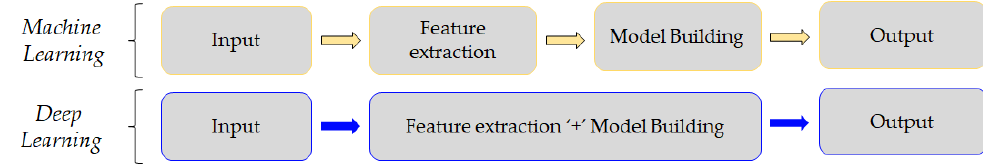
Figure 3. Model building process in machine learning and deep